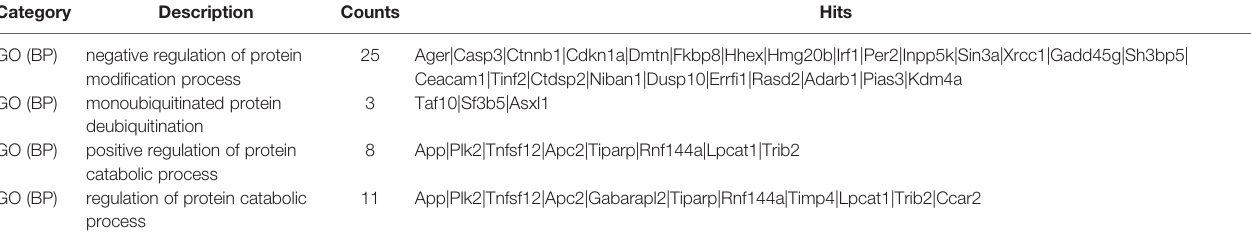
TABLE 1 | Functional terms and number of genes related to MAPK pathway in functional clustering results. Category